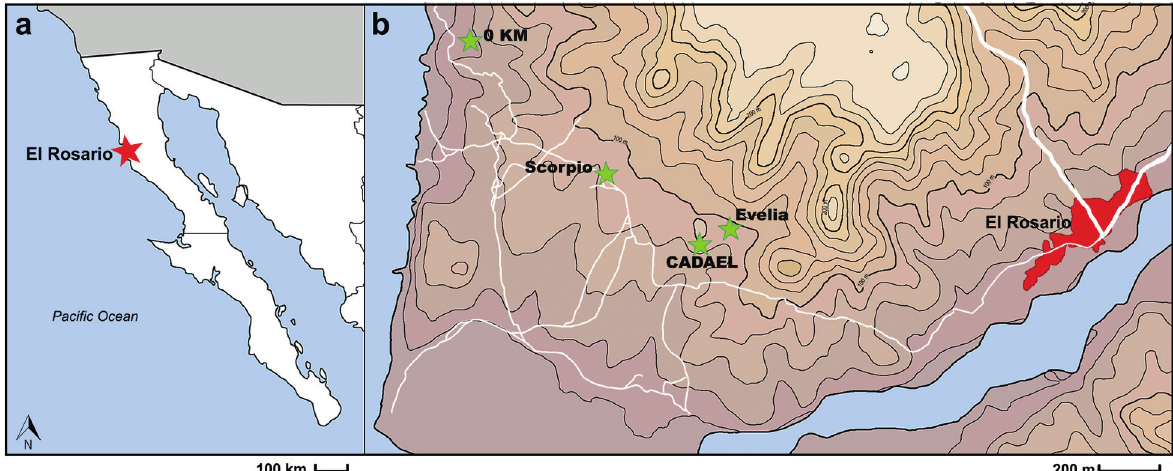
Figure 1 - a , location of the town of El Rosario, Baja California, Mexico; b , enlarged map of El Rosario area showing the four microsites where the referred specimens have been collected: Evelia (IGM 4970, IGM4971, IGM4972); 0KM